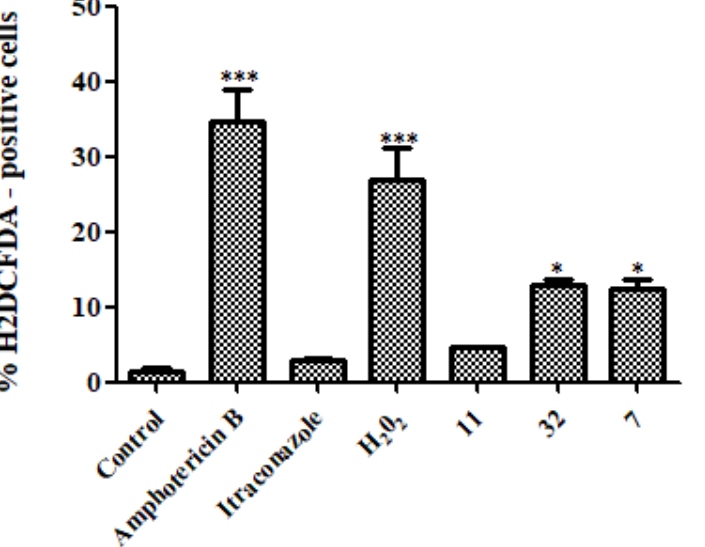
Figure 11. Measurement of ROS production after treatment of H. capsulatum EH-315 with 11 , 32 , 7 , AmB, ITZ, and hydrogen peroxide. The drug AmB, hydrogen peroxide, and compounds 32 and 7 induced ROS formation when compared to the control without treatment. Treatment with ITZ did not induce ROS formation when compared to the control. * p < 0.05; *** p < 0.001.